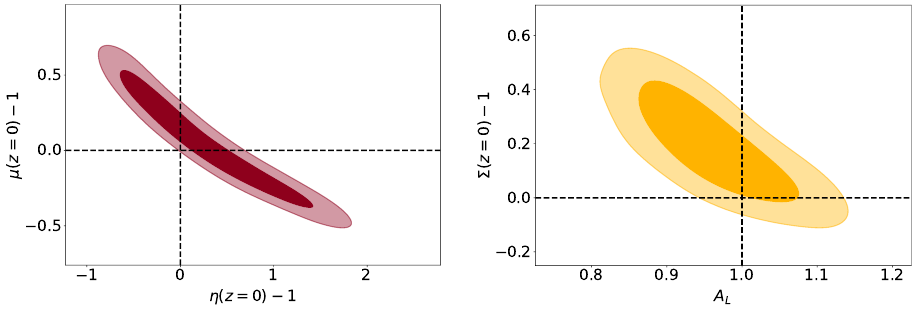
Figure 2. 68% and 95% confidence level contours for µ ( z = 0 ) − 1 and η ( z = 0 ) − 1 ( left ), and for Σ ( z = 0 ) − 1 and A L ( right ). The dashed lines show the expected values in a GR-